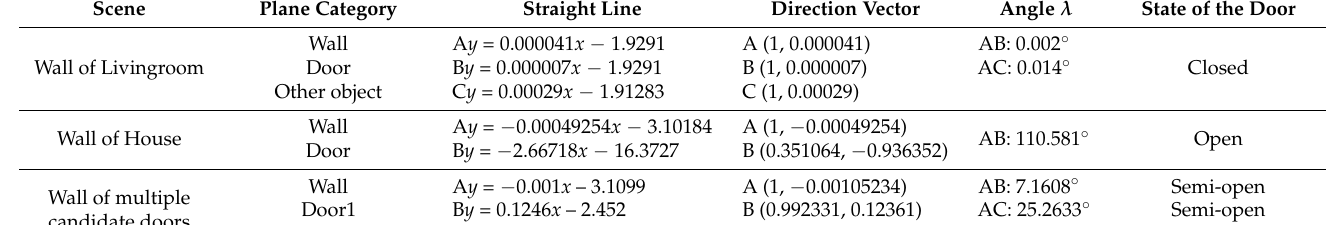
Figure 11. Reconstruction results. ( a ) Boundary point; ( b ) projection point; ( c ) straight-line fitting; ( d ) wall model.